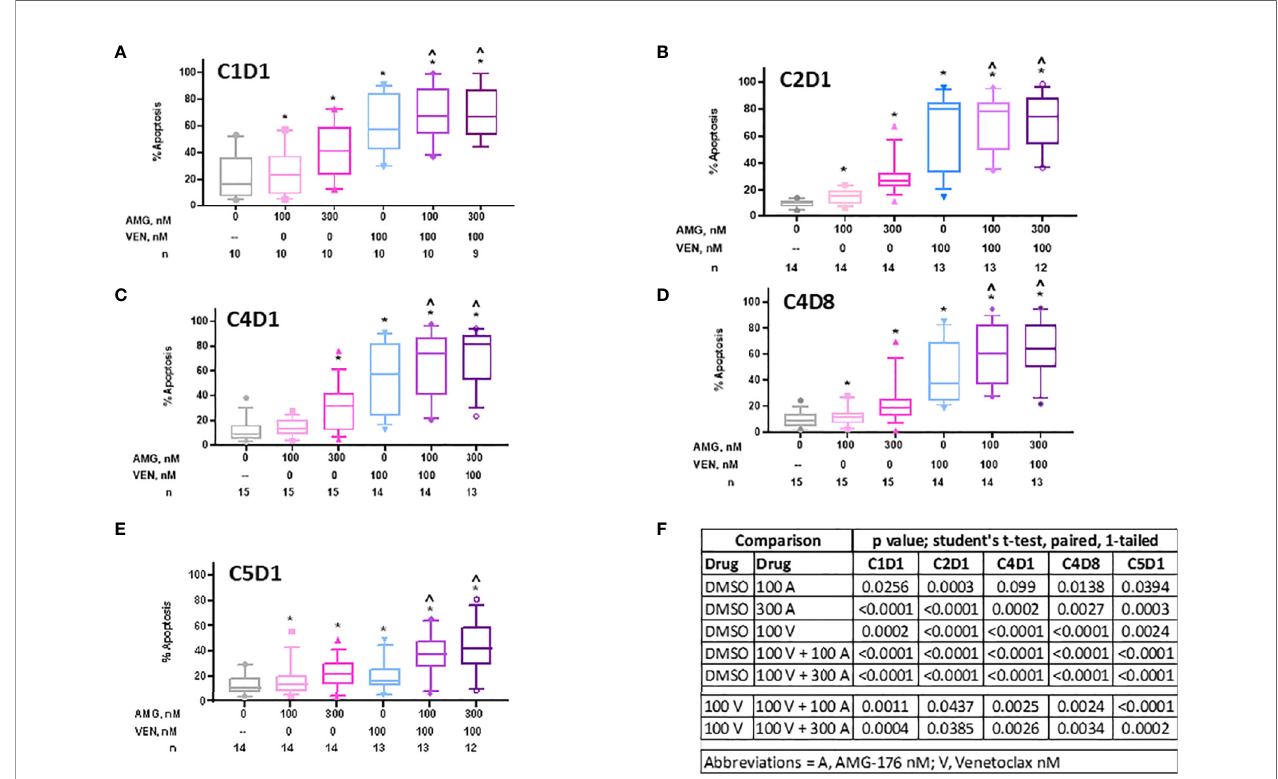
FIGURE 3 | Sensitivity of PBMCs obtained during ibrutinib monotherapy and ibrutinib plus venetoclax therapy to AMG-176, venetoclax, or combination. PBMCs from patients during therapy were obtained and treated ex vivo with DMSO (0.1%), 100 nM AMG-176, 300 nM AMG-176, 100 nM venetoclax, or combination of AMG-176 at both concentrations with venetoclax. Cell death was determined using fl ow cytometry after Annexin V/propidium iodide (PI) staining. (A) PBMCs were obtained at baseline, i.e., C1D1. (B) PBMCs were obtained after one cycle of ibrutinib, i.e., C2D1. (C) PBMCs were obtained after three cycles of ibrutinib, i.e., C4D1. (D) PBMCs were obtained after addition of venetoclax for one week, i.e., C4D8. (E) PBMCs obtained after 4 cycles of ibrutinib and one cycle of venetoclax, i.e., C5D1. AMG, AMG-176, and VEN, venetoclax. Box plots and whiskers represent 10 – 90 percentile and horizontal line is median value. Number (n) of patients for each determination are listed under abscissa. (F) P-values were determined for different comparisons for data in panels (A – E) . * and ^ indicate p values <0.05 compared to DMSO or 100 V, respectively. C, cycle and D,